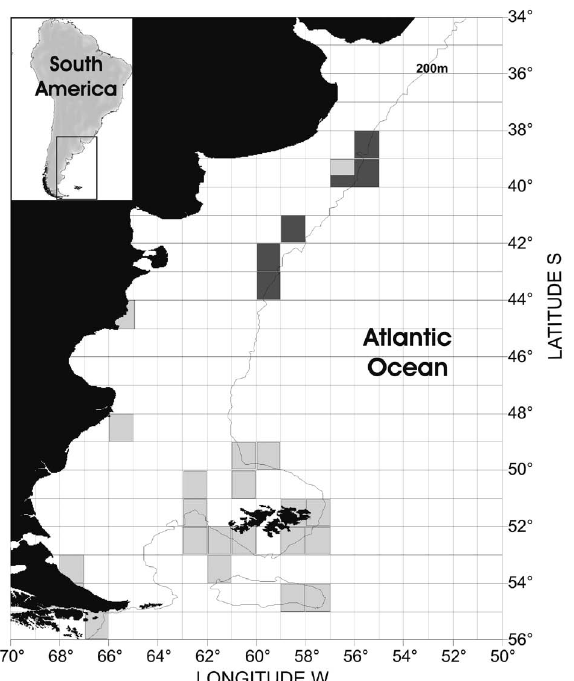
Fig . 1. – Distribution of Mycale ( A .) magellanica (Ridley, 1881) in the Argentine Sea. Light shadow areas represent previous records, dark shadow areas represent sampling sites of the present